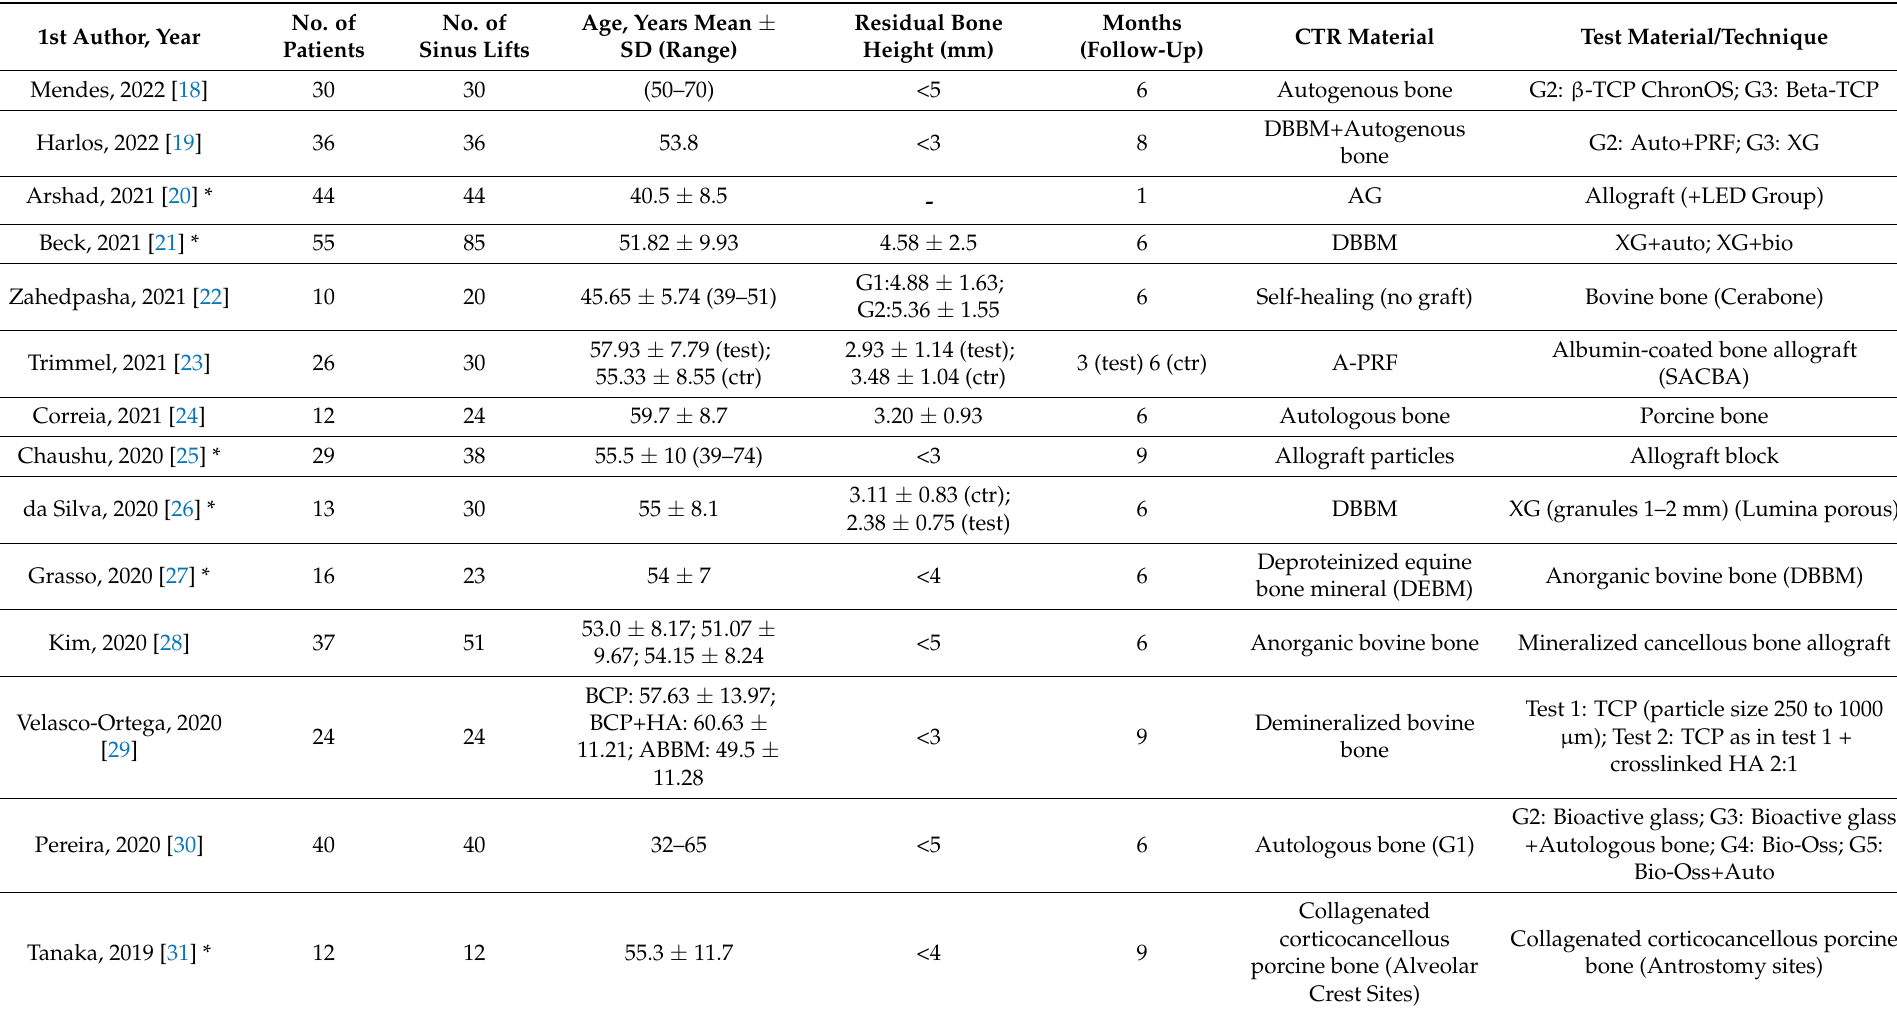
Table 1. Characteristics of the included